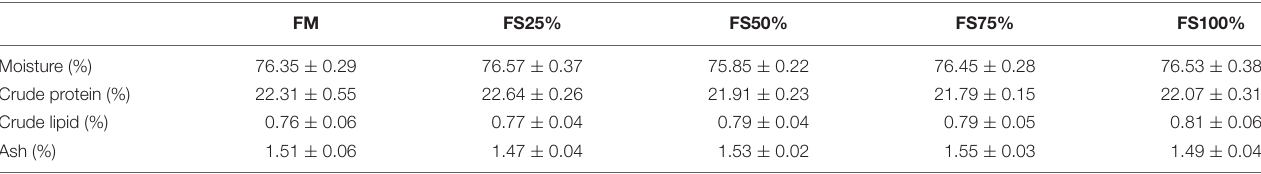
TABLE 6 | Proximate moisture, protein, lipid, and ash (% of wet weight) composition of shrimps fed with different experimental diets for eight weeks (means of triplicate ± SD). FM FS25% FS50% FS75% FS100%